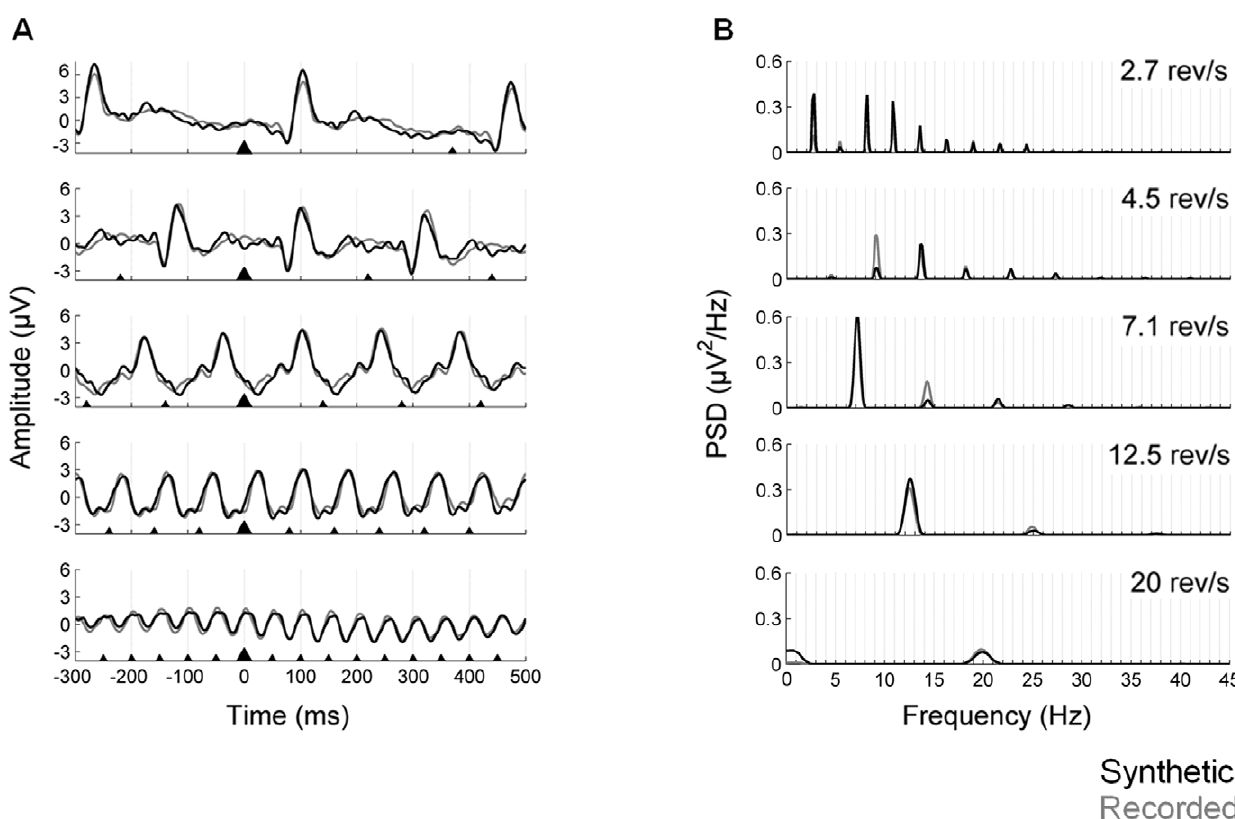
Figure 5. Synthetic waveforms obtained from linear superposition of transient templates (Experiment 1). The synthetic data are shown in black; the recorded data have been overlaid in grey for comparison. A , Grand-average waveforms (800 ms time window; 300 ms pre-stimulus) of the synthetic data at the five different rates. The triangles indicate stimuli onset; the largest triangle represents the zero time point. B , Power spectral densities of the grand-average waveforms.